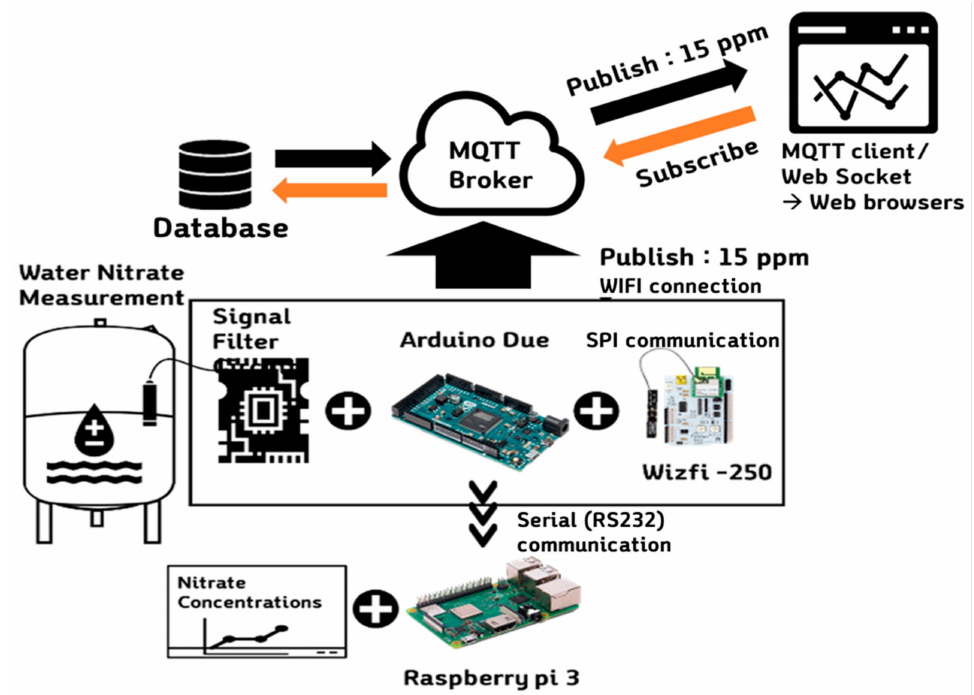
Figure 1. Configuration of Internet-of-Things (IoT)-based online water quality measurement